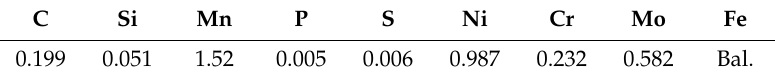
Table 2. Chemical composition of SA508 material